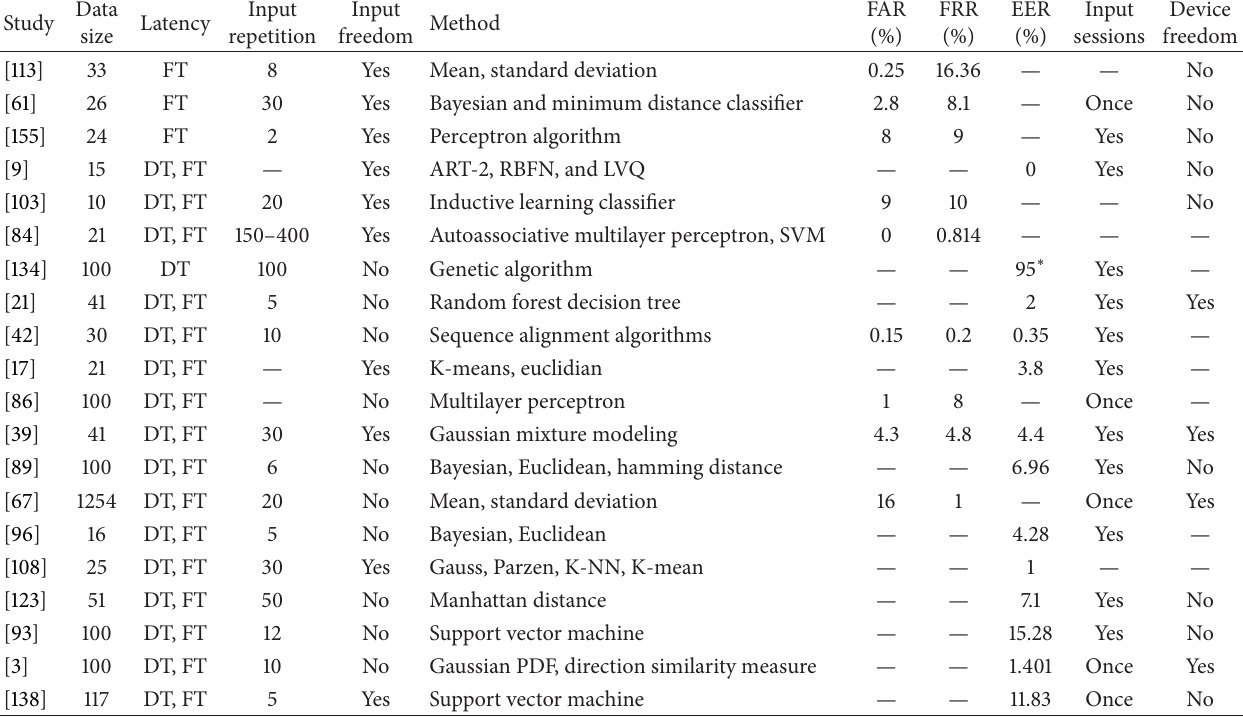
Table 4: Comparison between research works with static authentication mode (short inputs). Data Study size